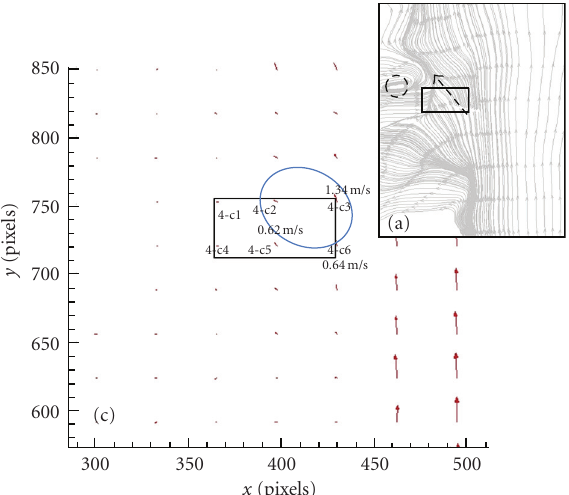
Figure 4: (a) Streamlines passing through the flame edge of case 1. (c) Velocity variation at the flame edge of case 1. The velocities in the rectangle are 0.28 m/s, 0.62m/s, 1.34 m/s, 0.35 m/s, 0.5 m/s, and 0.64m/s (ordered by left to right and top down).